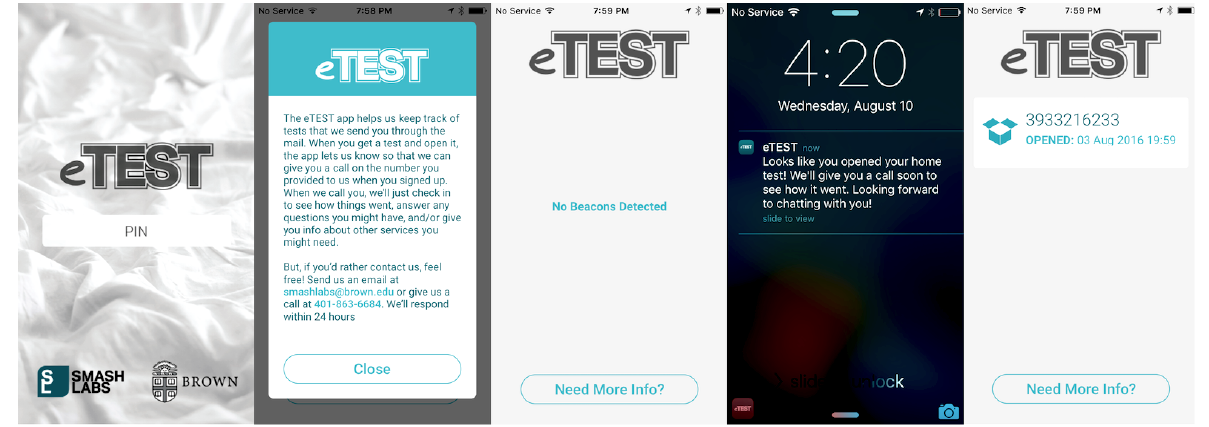
Figure 2. eTEST smartphone app